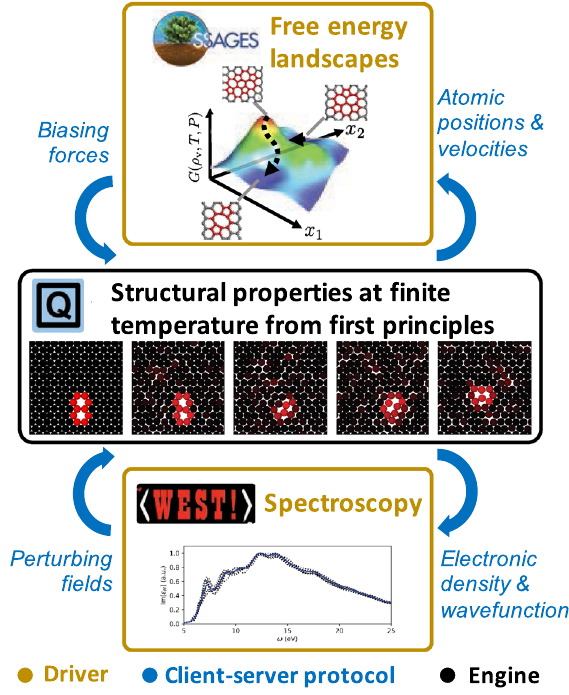
Fig. 1 In vivo coupling of codes using a client-server model. Basic physical quantities (in blue) exchanged between fi rst principles molecular dynamics simulations, advanced sampling techniques and calculations of spectroscopic properties. The codes used here (Qbox 14 ; SSAGES 15 ; WEST 16 ) are coupled using a driver-engine approach, where data-exchange operations are regulated by the client-server